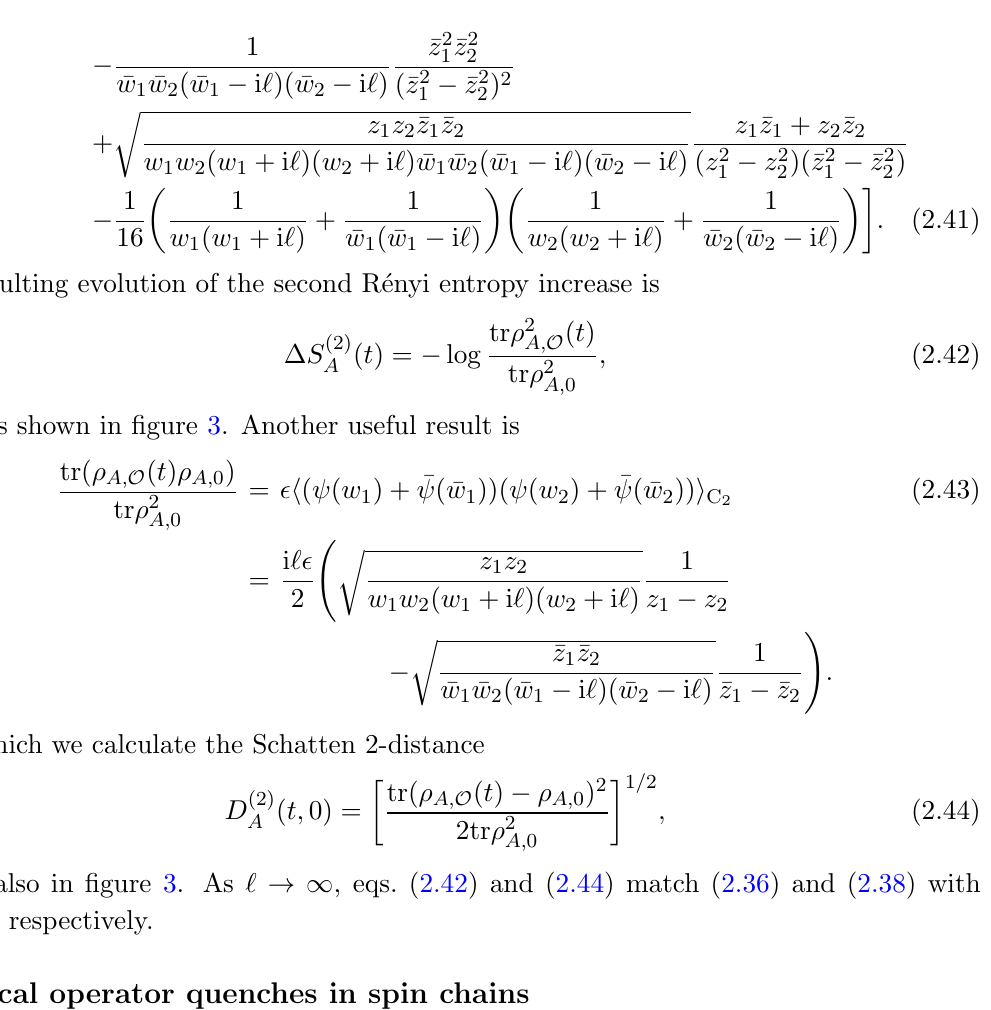
Figure 3 . E(cid:11)ect of the cuto(cid:11) in a two-dimensional CFT. Here we consider the free massless fermion theory and the insertion of the operator (2.39). We set the UV cuto(cid:11) of the operator to be (cid:15) = 1 and we report results for various values of ‘ . The time evolution of the second order R(cid:19)enyi entropy (cid:1) S (2) ( t ) (2.42) and Schatten 2-distance D (2) ( t; 0) (2.44) are reported on the left and right A A respectively. They slowly approach the results for (cid:15) ! 0 as ‘ ! 1